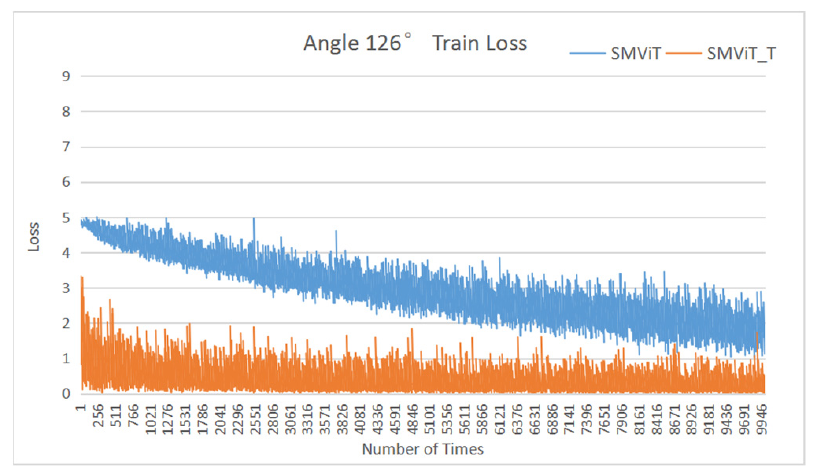
Figure 6. Loss change when the view is 126°.